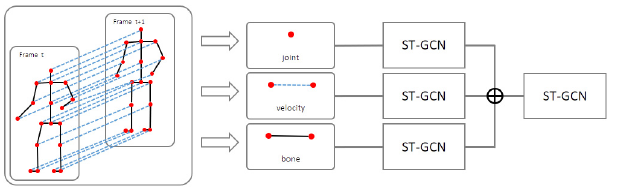
Figure 3. Overall pipeline of our proposed approach.